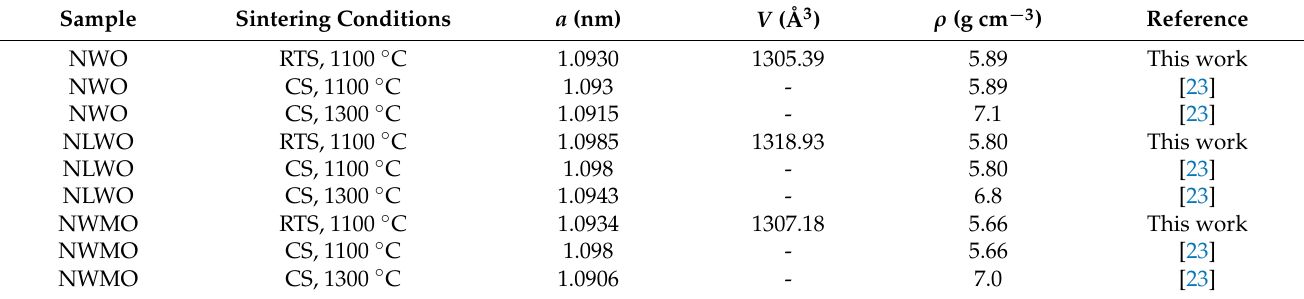
Table 1. The unit cell parameter ( a ), cell volume ( V ) and true density ( ρ ) of samples obtained by mechanical activation and sintered using electron beams (RTS) and conventional sintering (CS)